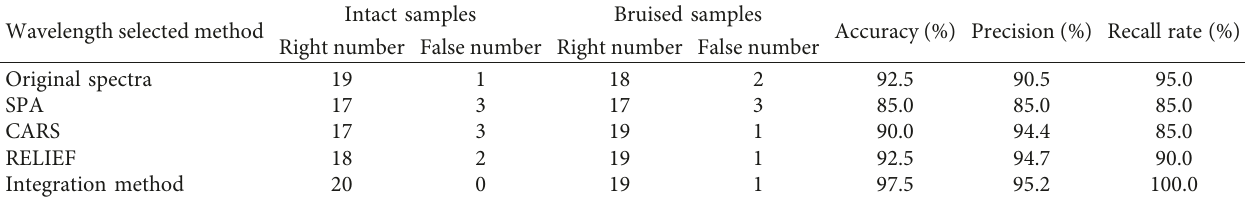
Table 3: The detection results of the ELM